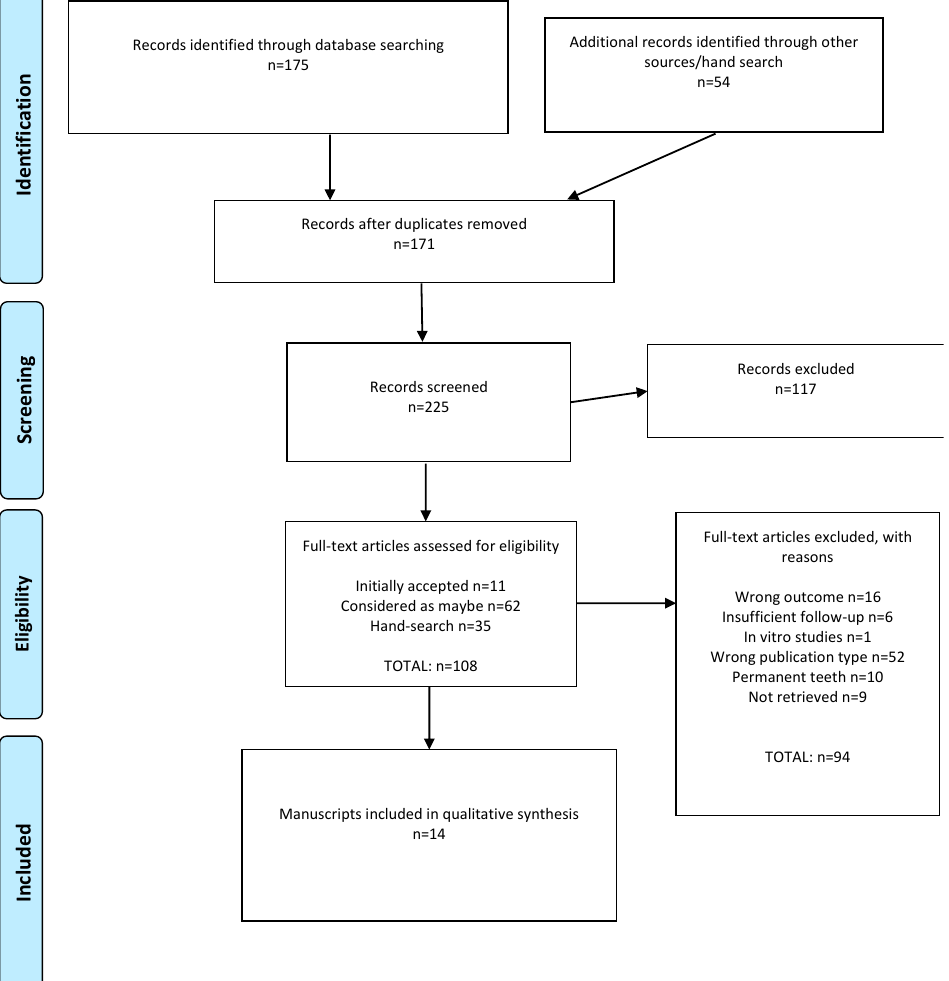
Figure 1. PRISMA flow diagram.